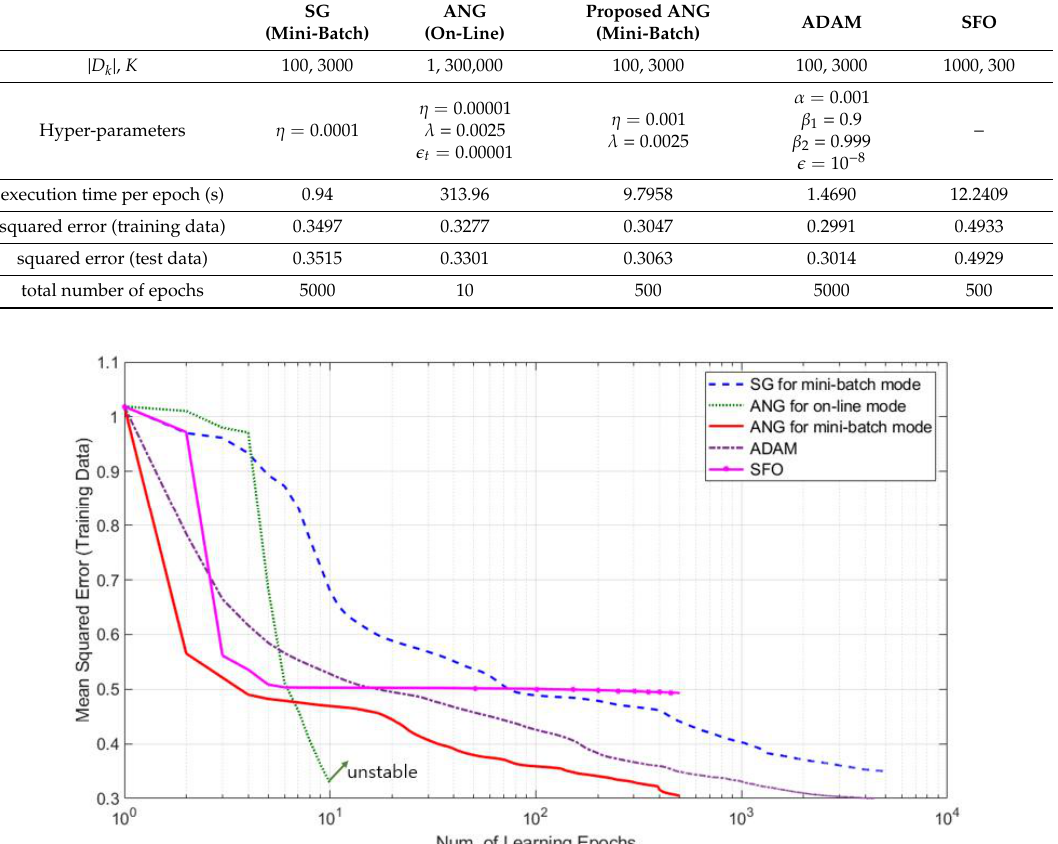
Table 3. Hyper parameters and training performances on 3D elevation data.